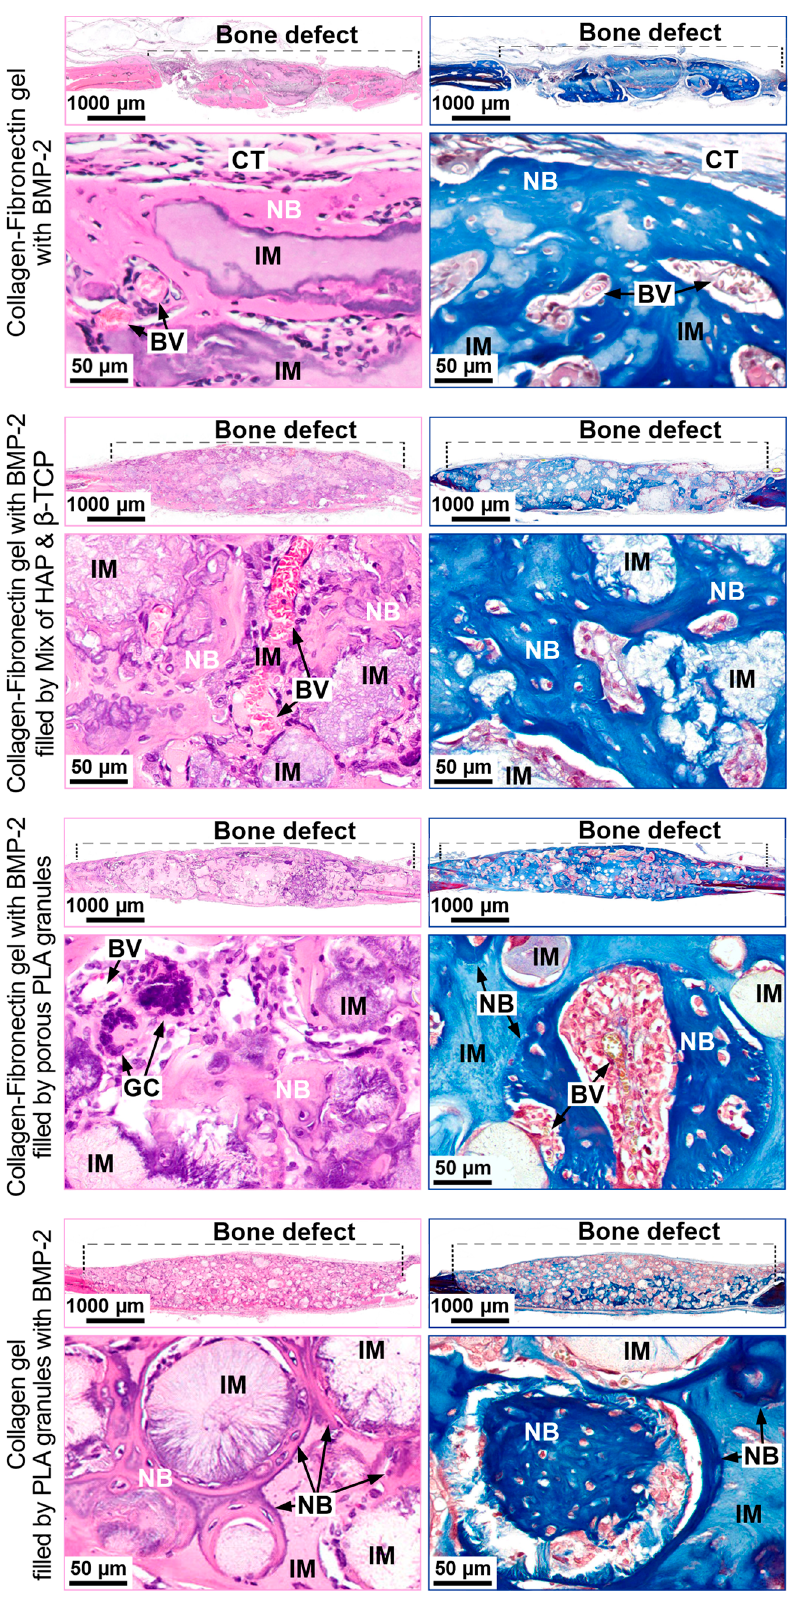
Figure 5. Implantation of materials into rat critical-size calvarial defect. H&E ( left column) and Masson ( right column) staining. IM—Implanted material, CT—connective tissue, BV—blood vessel, NB—newly formed bone, GC—giant cells.